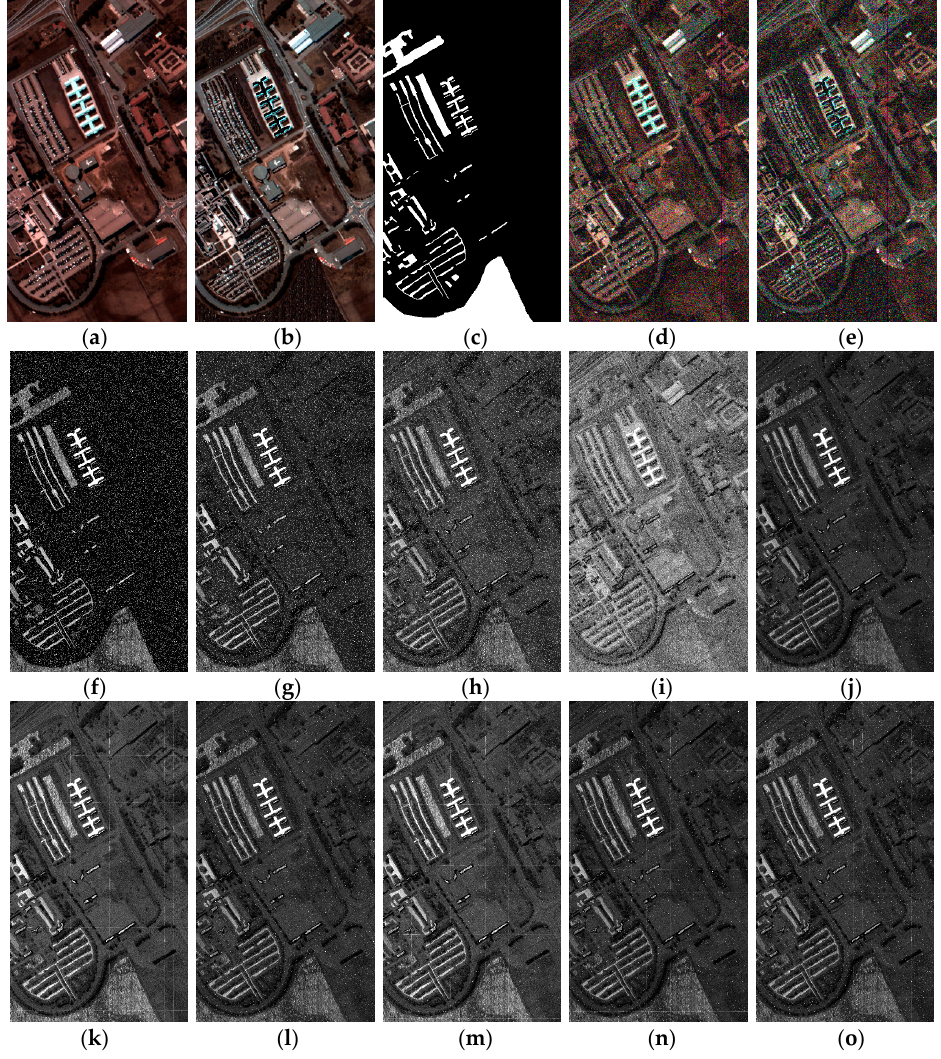
T ; 10 T ; and ( e ) T of Data 10; 1 2